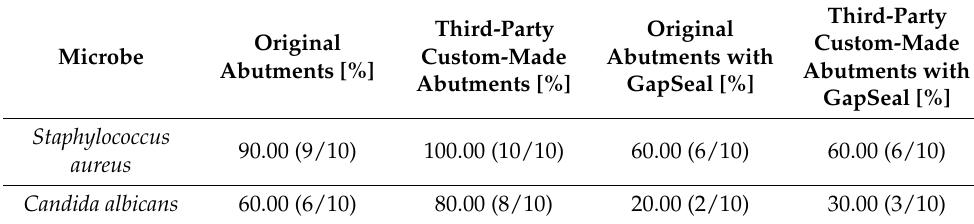
Table 2. The frequencies of bacterial and fungal microleakage (GC Aadva Standard implants).